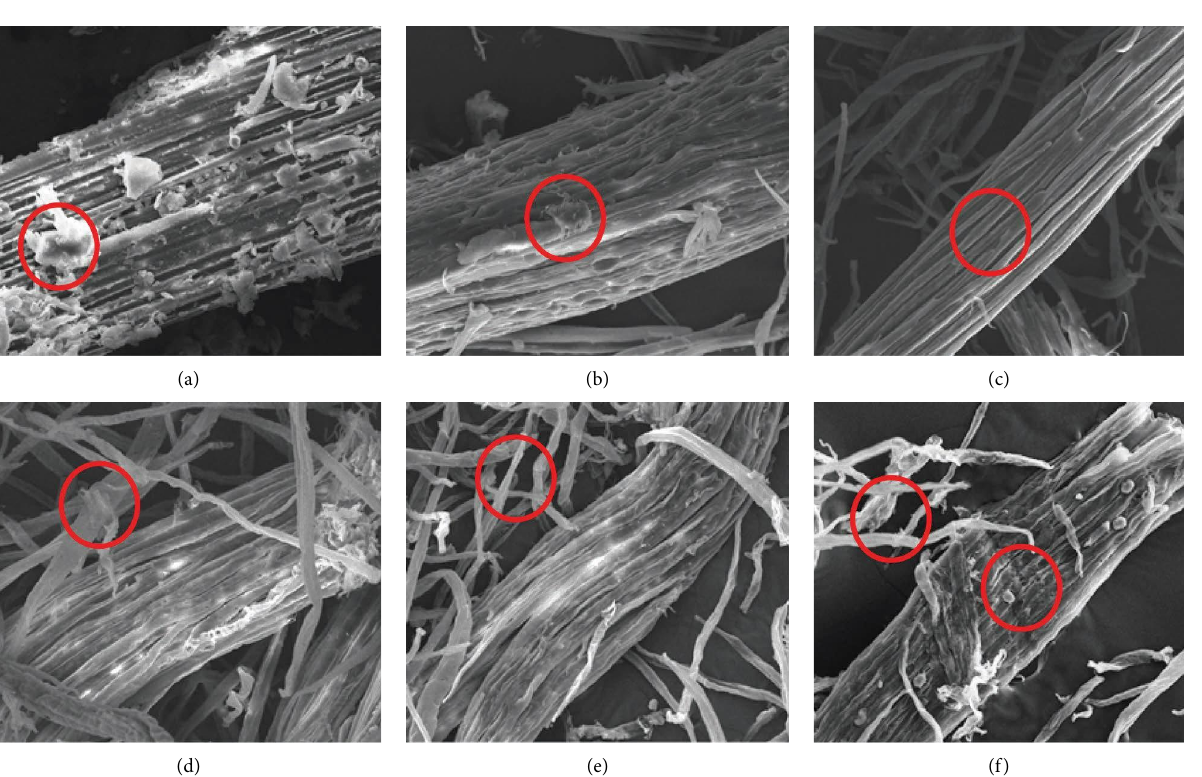
Figure 7: Morphology of OPEFB and cellulose fbers using 1000x magnifcation SEM, 100mm size: (a) OPEFB fber; (b) OPEFB bleached fber; (c) OPEFB cellulose of NaClO 2 1.5% 3 h; (d) OPEFB cellulose of NaClO 2 3% 2h; (e) OPEFB cellulose of NaClO 2 3.22% 1h; and (f) OPEFB cellulose of NaClO 2 4.5% 3 h.